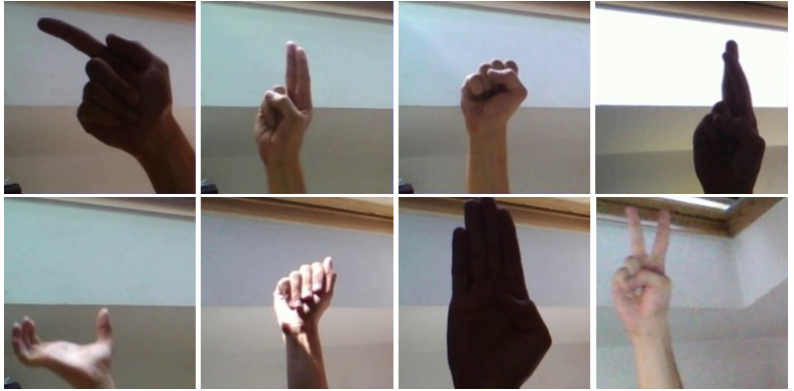
Figure 6. Sample images from ASL dataset.